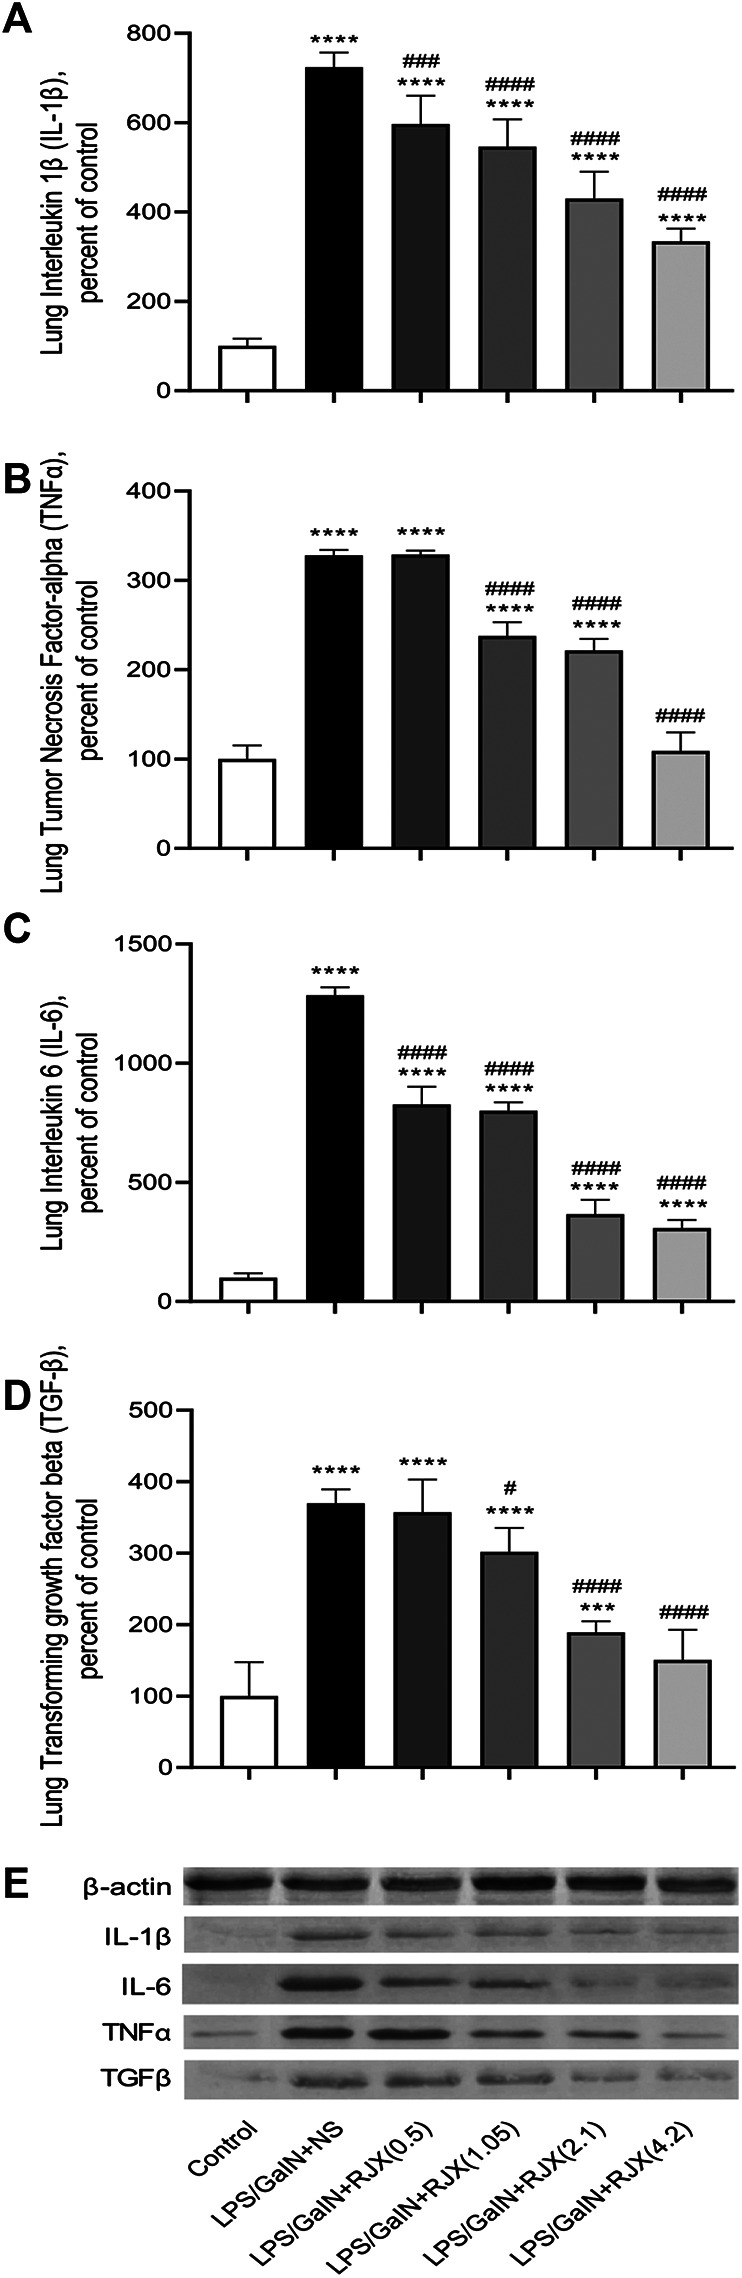
Rejuveinix (RJX) Prevents Pro-inflammatory Cytokine Response in the Lungs of Mice Challenged with Lipopolysaccharide-Galactosamine (LPS-GalN). Mice were treated with i.p injections of RJX (0.5, 1.05, 2.1, 4.2 ml/kg, 0.5 ml/mouse) or normal saline (NS) 2 h before and 2 h post-injection of LPS-GalN. Except for untreated mice (Control), each mouse received 0.5 ml of LPS-GalN (consisting of 100 ng of LPS plus 8 mg of d-galactosamine) i.p. The RJX dose levels (in ml/kg) are indicated in parentheses. See text for discussion of results. Depicted are the results of Western blot analyses of cytokine expression in the pooled lung tissue samples from mice in various treatment groups. Panel A: Lung IL‐1b levels; Panel B: Lung TNF‐a levels; Panel C: Lung IL‐6 levels; D: Lung TGF‐b levels; E: Immunoblot. Results are expressed as percent of control with the expression level in the lung tissue sample from untreated control mice taken as 100% for comparisons. The bar represents mean and standard deviation. Immunoblotting with an anti-actin antibody was used to ensure equal protein loading. (ANOVA and Tukey’s post-hoc test. Statistical significance between groups is shown by: ***p < 0.001; ****p < 0.0001 compared as control group and, #p < 0.05; ###p < 0.001; ####p < 0.0001 compared as LPS/GaIN + NS group).